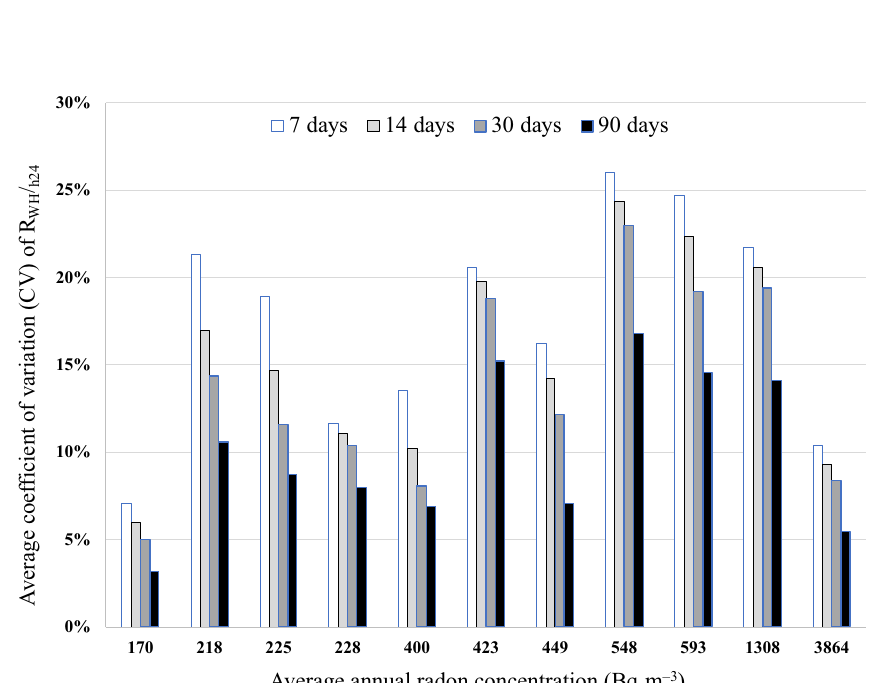
Figure 5. Average coefficient of variation of the ratio between RnC WH and RnC H24 (R WH / h24 ) estimated for each 7-day, 14- day, 30-day, and 90-day period of the year for the 11 rooms for which annual radon measurements with active devices were performed. On the x-axis, the average annual radon concentrations for these 11 rooms are